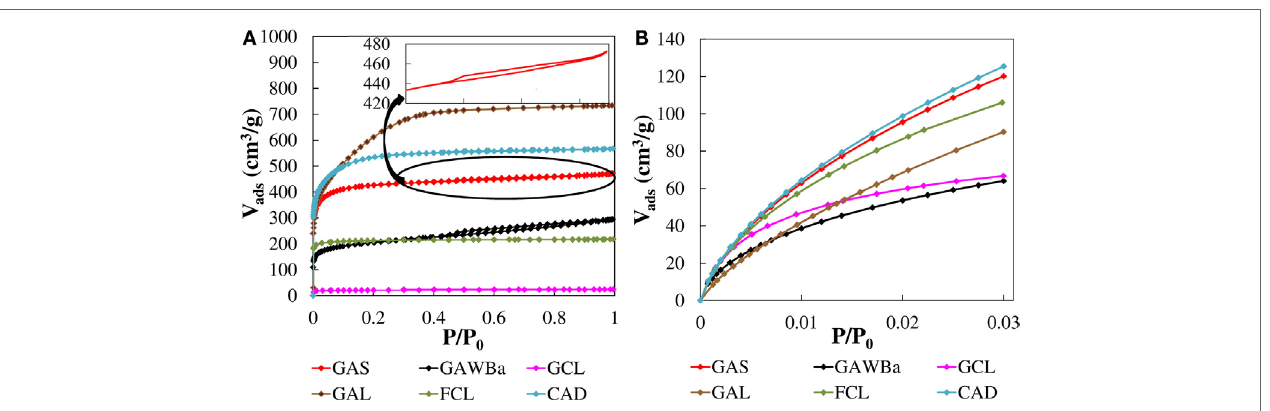
FigUre 2 | n 2 adsorption–desorption isotherms at − 196°c (a) and cO 2 adsorption isotherms at 0°c (B) of the different carbon materials .